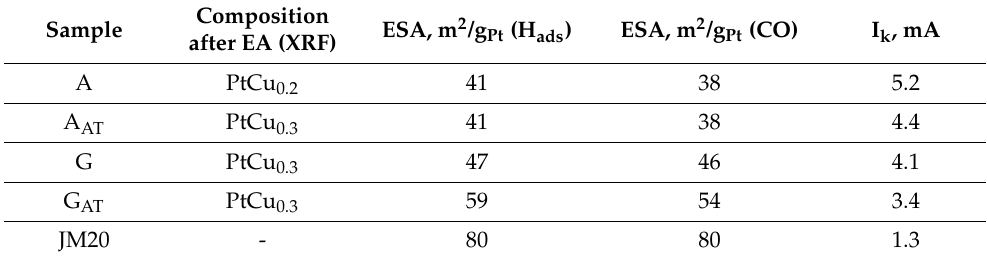
Table 2. The composition and electrochemical characteristics of the activated PtCu/C